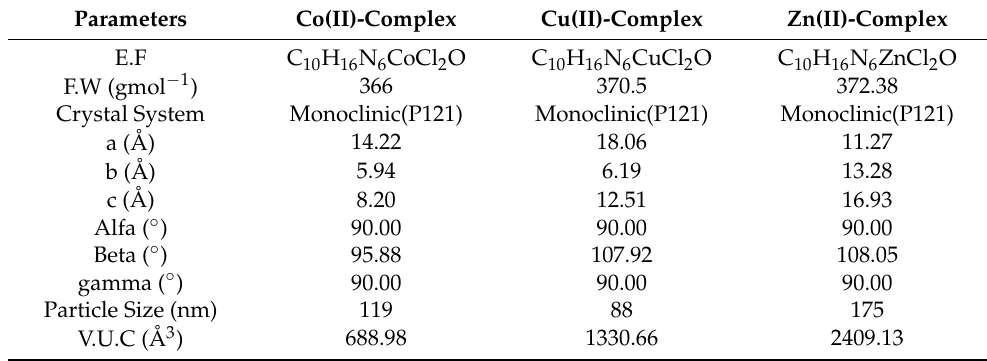
Table 3. XRD data of the Co(II), Cu(II), and Zn(II) complexes.